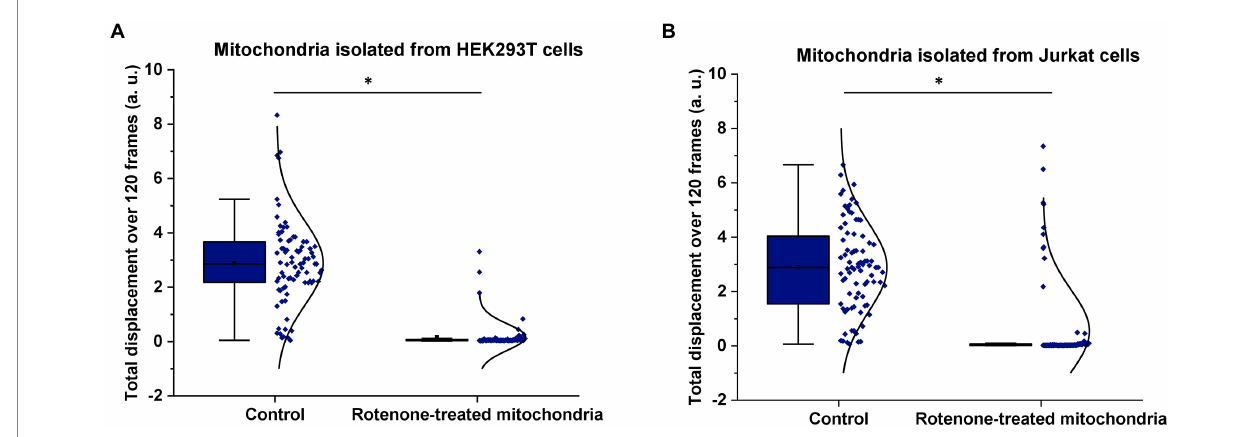
FIGURE 4 Effect of rotenone on mitochondrial nanomotion. Mitochondria were either untreated or exposed to 1 μ M rotenone for 40 min. Mitochondrial displacement values are expressed in arbitrary unit (a.u.). (A) Effect of rotenone on the 2D displacement of mitochondria isolated from HEK293T cells. In the control treatment, the displacement of 82 single mitochondria were measured whereas 85 in the case of rotenone treatment. (B) Effect of rotenone on the 2D displacement of mitochondria isolated from Jurkat cells. In the control treatment, 83 different mitochondria were measured whereas 90 in the case of rotenone treatment. Results are representative of three independent experiments. * p < 0.005 from two-sample t